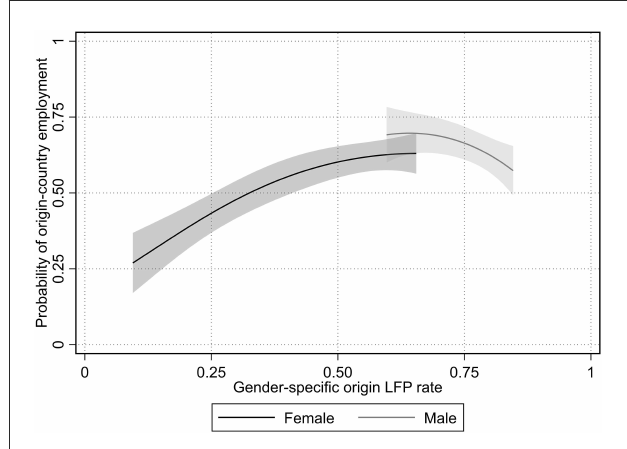
FIGURE1 Probability of origin-country employment based on a logistic regression with gender-specific origin-country LFP (squared polynomial). Prediction ranges from 5th to 95th percentile of origin-country LFP.